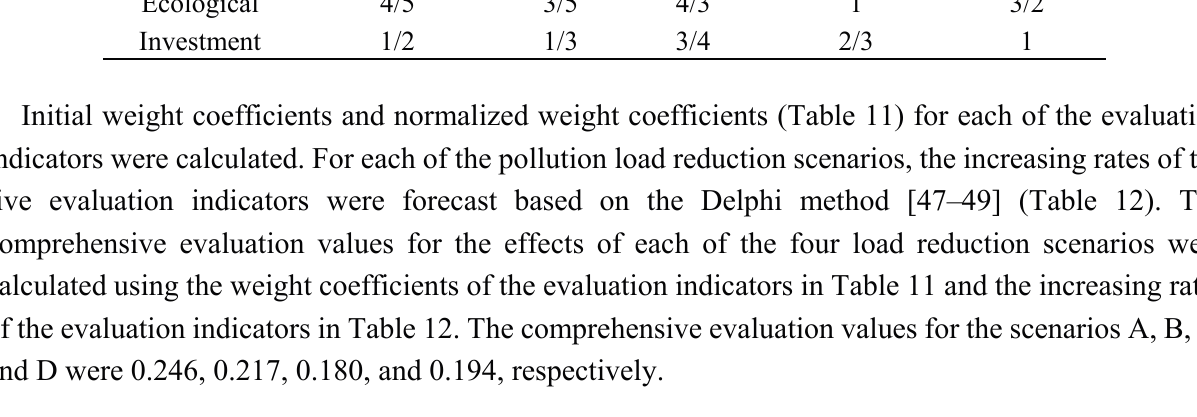
Table 11. Weight coefficients of the evaluation indicators.